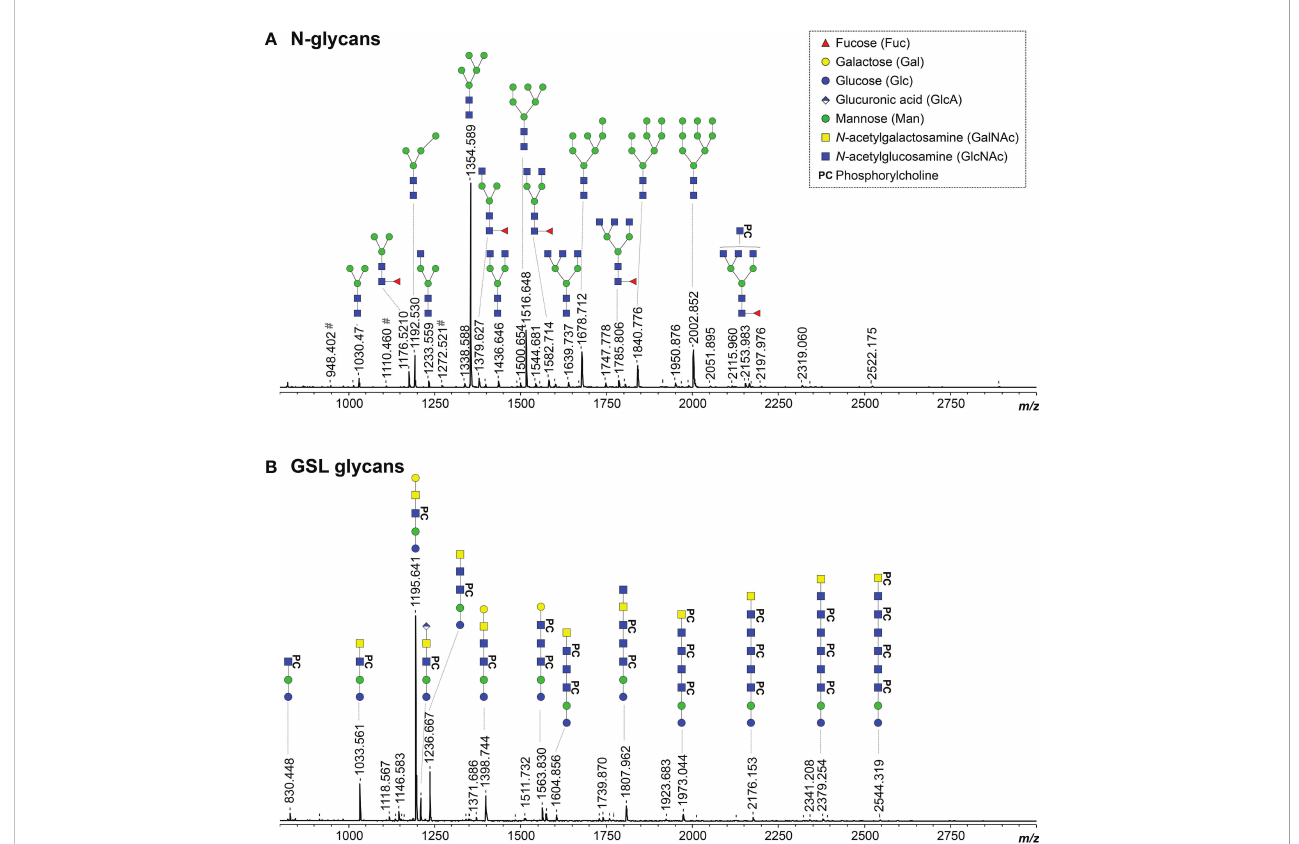
FIGURE 3 MALDI-TOF-MS of O. volvulus adult female worm N-linked and GSL glycans. O. volvulus glycoproteins were treated with PNGase F to release N-glycans (A) while EGCase I was used on glycolipids (B) . Enzymatically released glycans were then labelled with 2-AA and analyzed using MALDI-TOF-MS in negative-ion re fl ectron mode. Monoisotopic masses of measured signals are indicated and proposed glycan structures for ions with signal-to-noise ratios superior to 5 are depicted using the CFG nomenclature (see symbol key insert). # symbols signal m/z of glucose polymers from unknown origin. Compositions and structures were deduced using a panel of glycan sequencing techniques in combination with MALDI-TOF-MS/MS fragmentation, analogy with B. malayi and information from literature. See Table S4 for MALDI-TOF-MS spectra raw data and complete structural